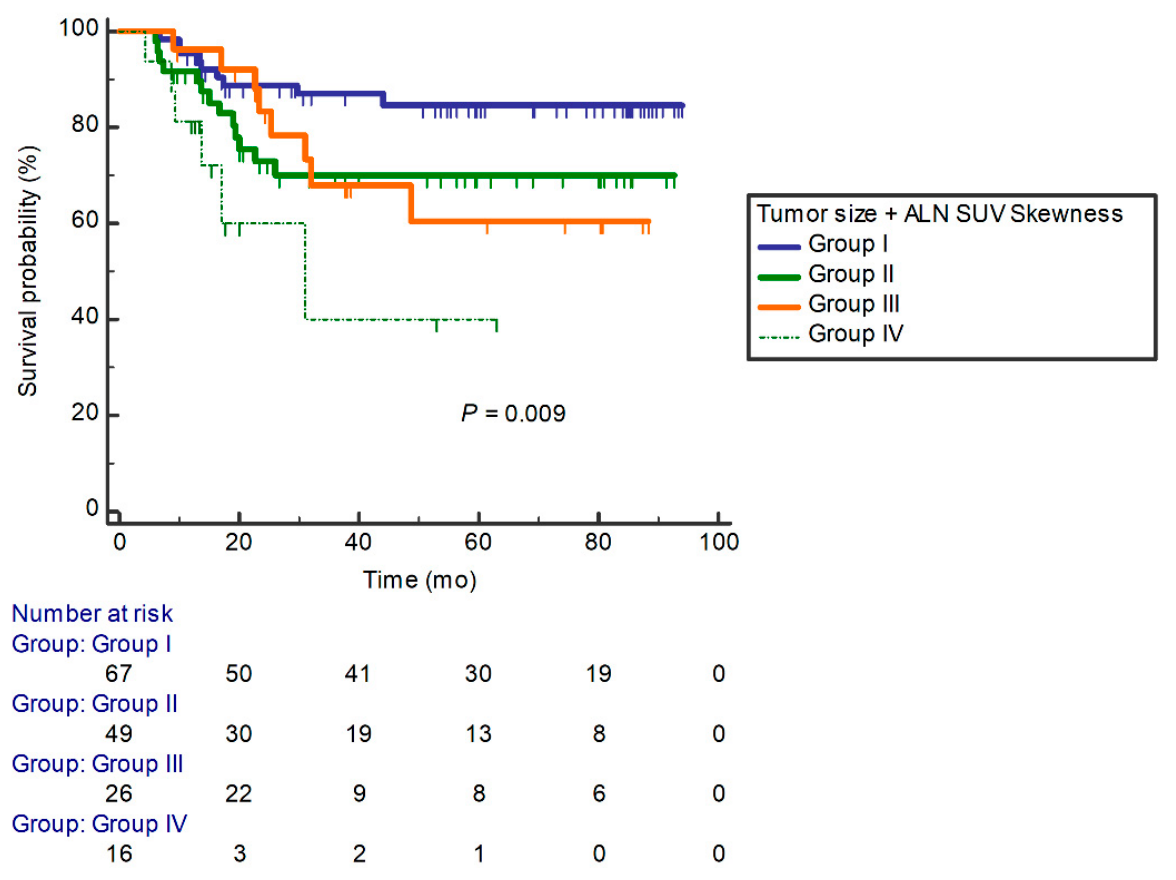
Figure 3. Combination model of clinical and ALN texture parameters for progression-free survival.